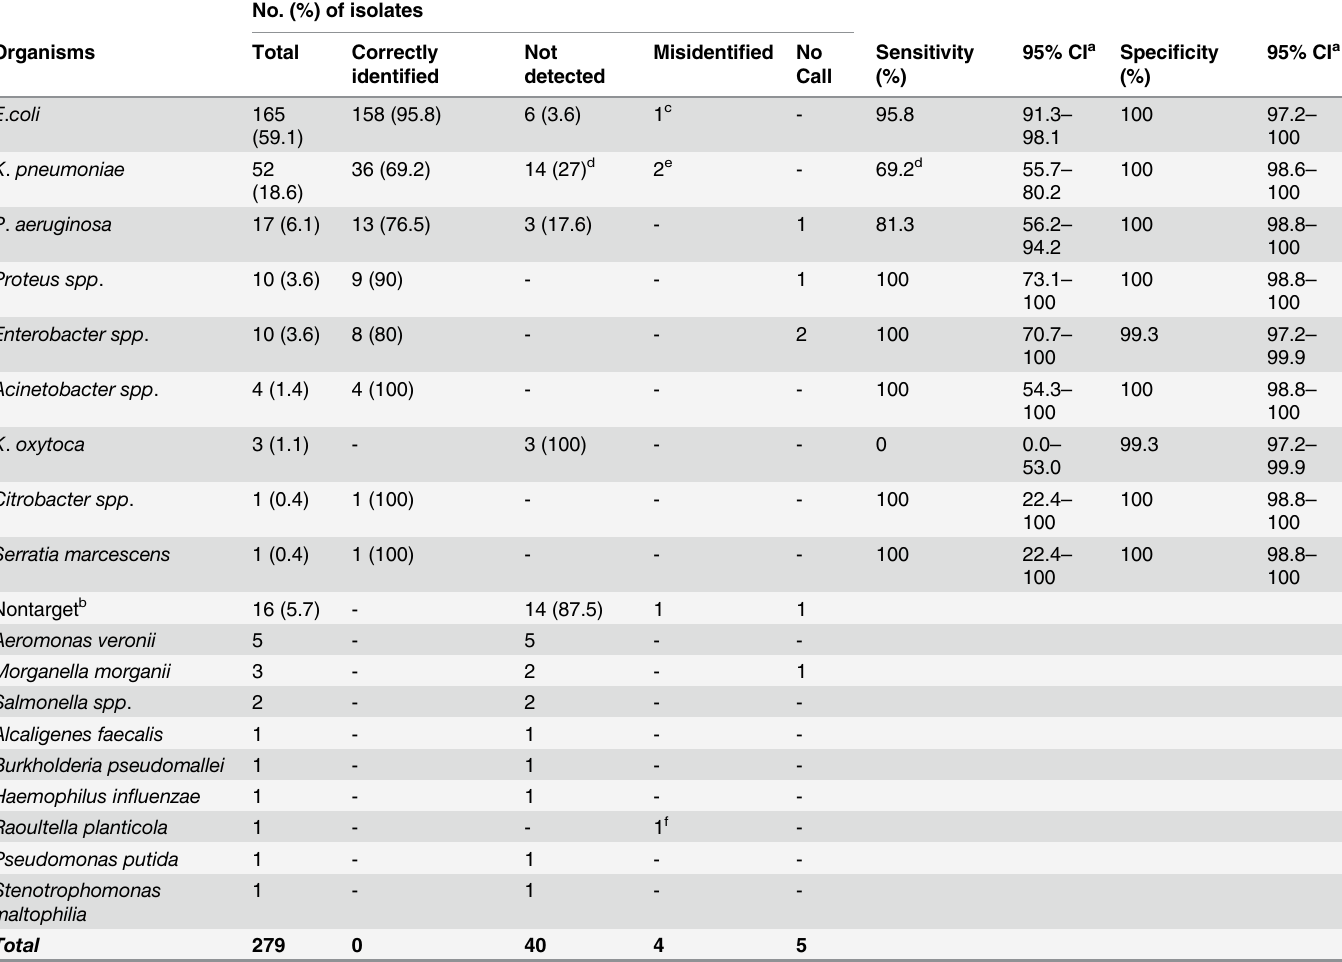
Table 4. Performance of BC-GN for idenifcation of Gram negative